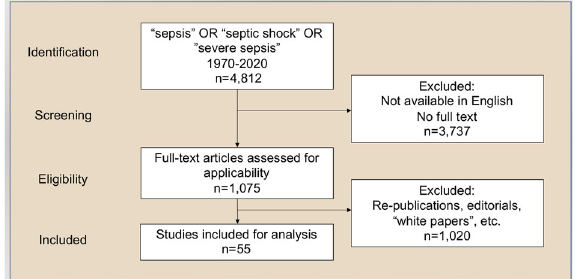
Fig. 1 Flowchart for study selection. Initial searches identi fi ed 4812 manuscripts. After removing duplicate, non-English, non-full-text citations, 1075 full-text manuscripts were reviewed against inclusion criteria. After exclusion, 55 unique studies were included in the analysis.